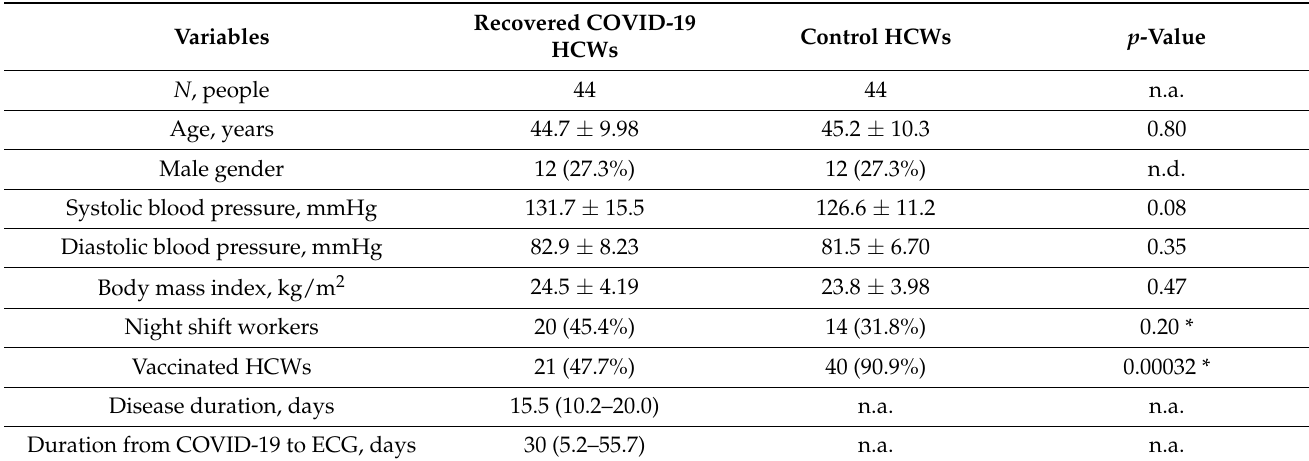
Table 1. Characteristics of the study